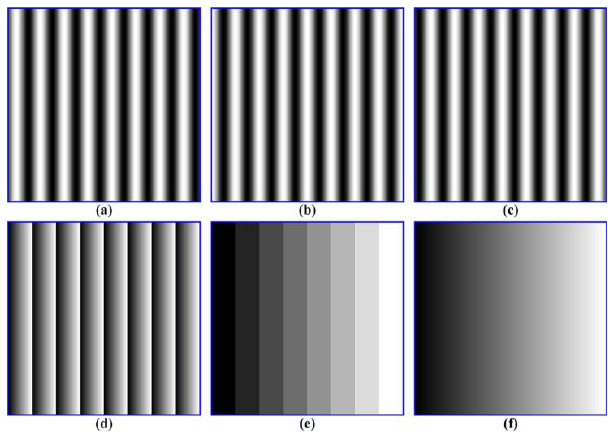
Figure 6. Simulation of depth plane z min . ( a – c ) Phase-shift patterns; ( d ) wrapped phase map; ( e ) minimum fringe order map k min ; ( f ) minimum phase map Φ min .